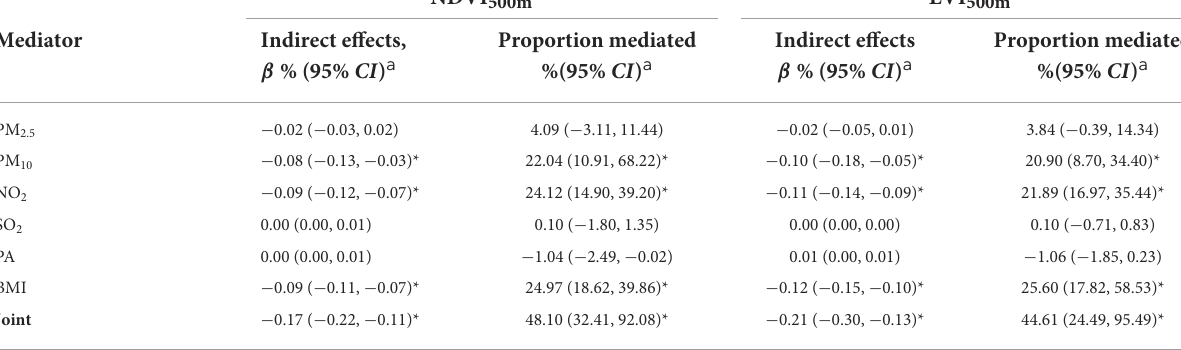
TABLE 4 Mediation of associations between residential NDVI 500m and EVI 500m and MetS risk a